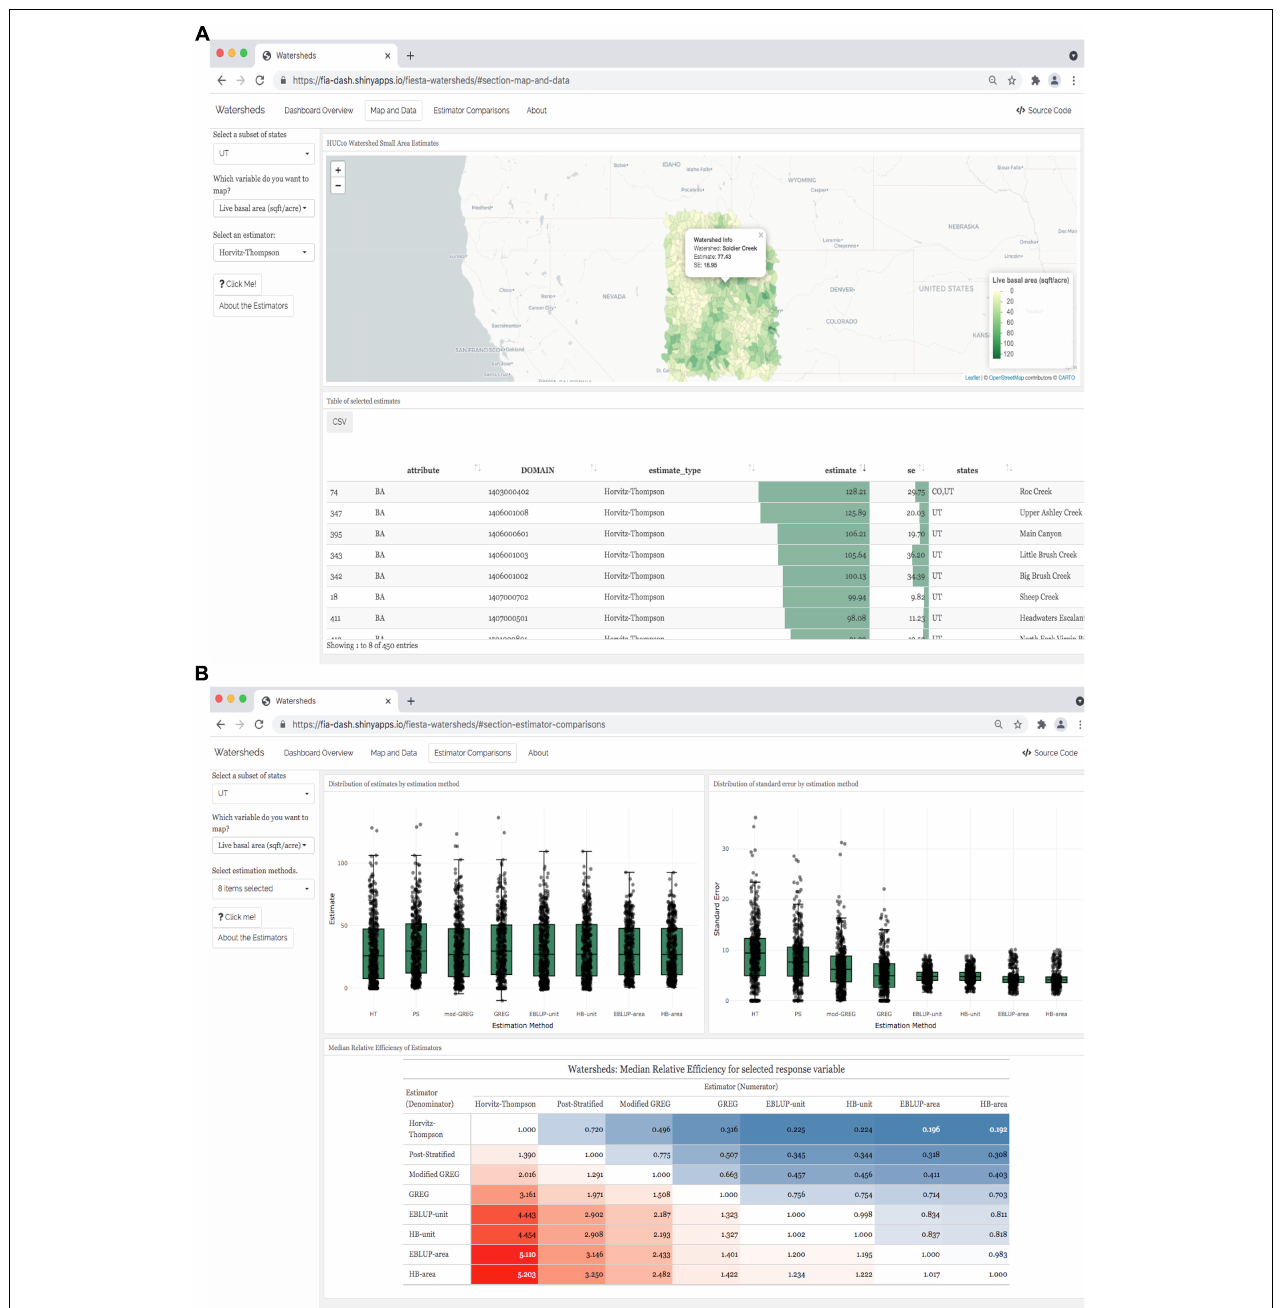
FIGURE 11 | Example views from the watershed dashboard available at https://ncasi-shiny-tools.shinyapps.io/Watersheds/. From the Maps and Data Tab (A) the user can select a state, which variable they are interested in and specify which of the design- or model-based estimates they would like to see. Then from the Estimator Comparisons Tab (B) , the user can compare the performance of any of the estimators for their variable and state of choice through graphs depicting the distribution of estimates and standard errors, as well as a table of relative efficiencies comparable to Table 2 , but for the users specified state and attribute. Dashboards in the same format have also been constructed for ecosubsections and counties, which can be accessed at https://ncasi-shiny-tools.shinyapps.io/ Ecosubsections/, and https://ncasi-shiny-tools.shinyapps.io/Counties/